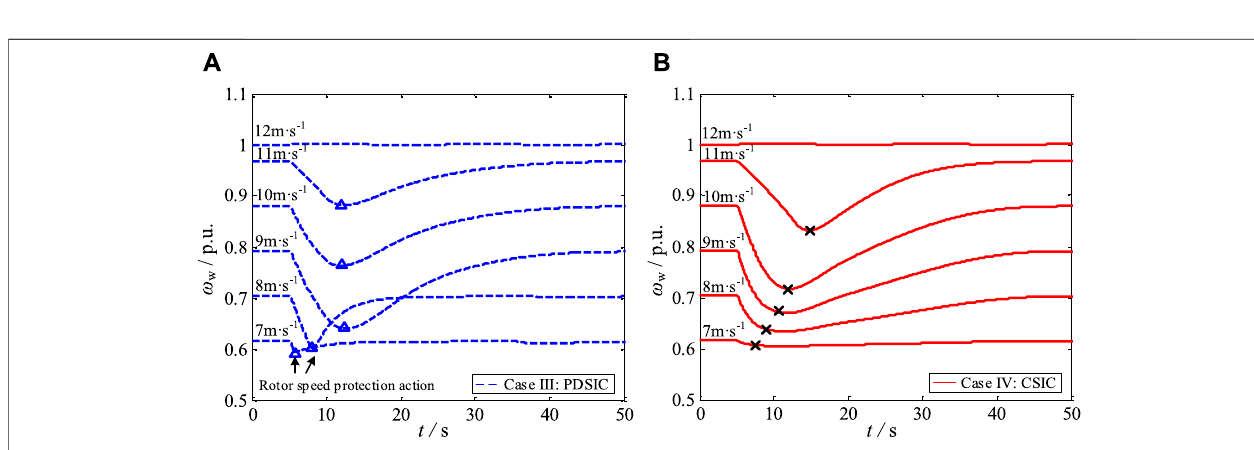
FIGURE 12 | Rotor speed of D-PMSGs operating at different wind speeds in (A) Case III and (B ) Case IV (wind farm #1).